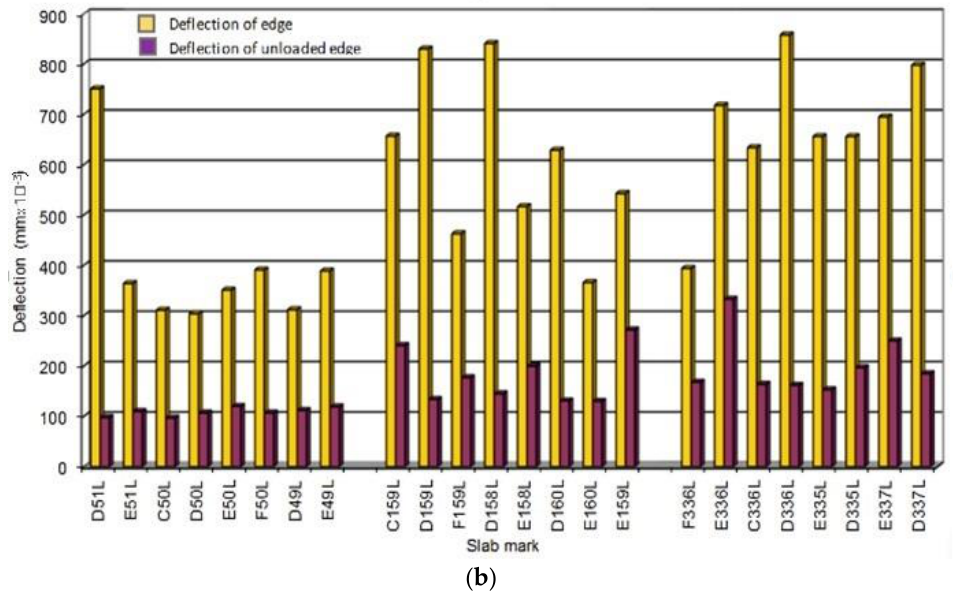
Figure 2. ( a ) Load transfer across transverse joints of RWY 13-31; and ( b ) load transfer across longitudinal joints (without any reinforcement) for RWY 13-31